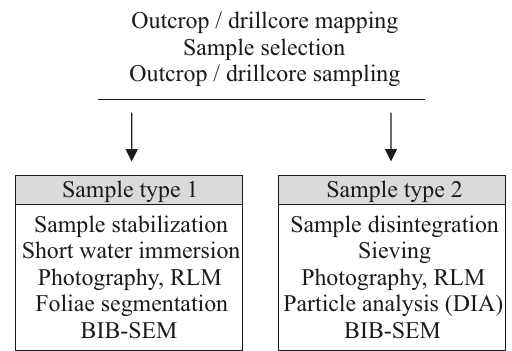
Figure 3. Sample types and corresponding workflow (RLM: re- flected light microscopy; DIA: digital image analysis; BIB: broad- ion beam; SEM: scanning electron microscopy).